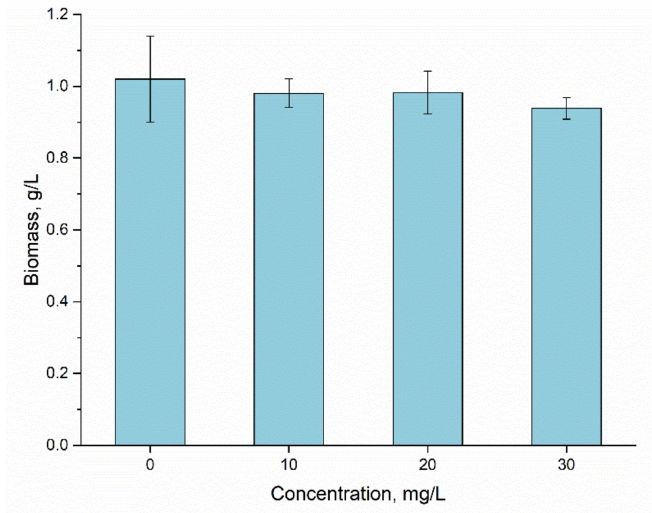
Figure 6. The effect of Er(III) at concentrations 10–30 mg/L on A. platensis